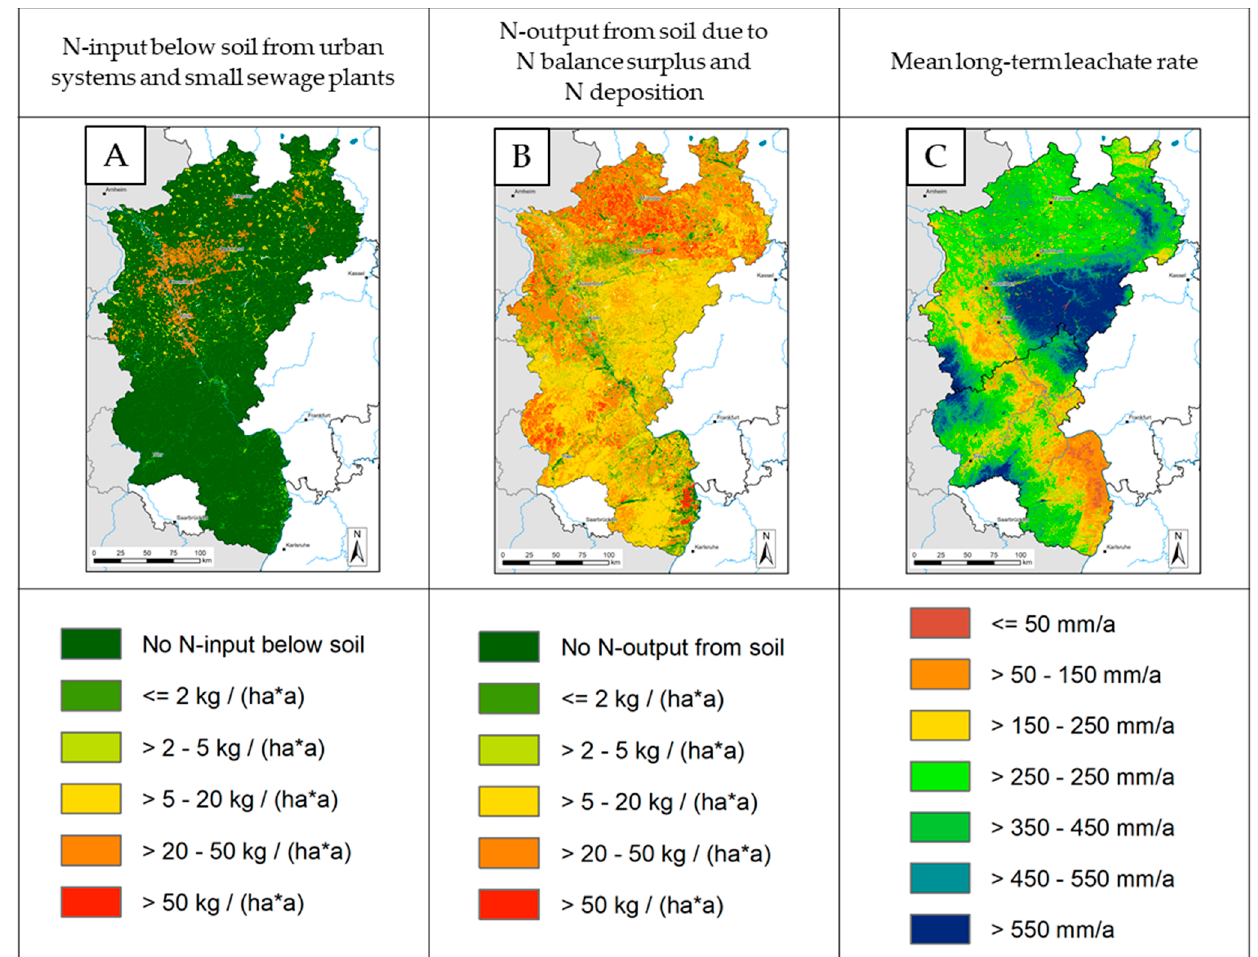
Figure 2. Relevant input parameters for calculating nitrate concentration in the leachate: Nitrogen input below soil from urban systems and small sewage plants ( A ), Nitrogen output from soil due to agricultural N balance surplus and atmospheric N deposition ( B ), and mean long ‐ term leachate rate ( C ).